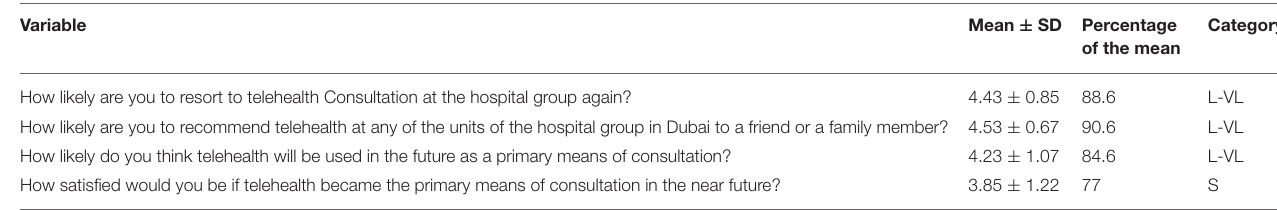
TABLE 3 | Output of descriptive quantitative analysis.